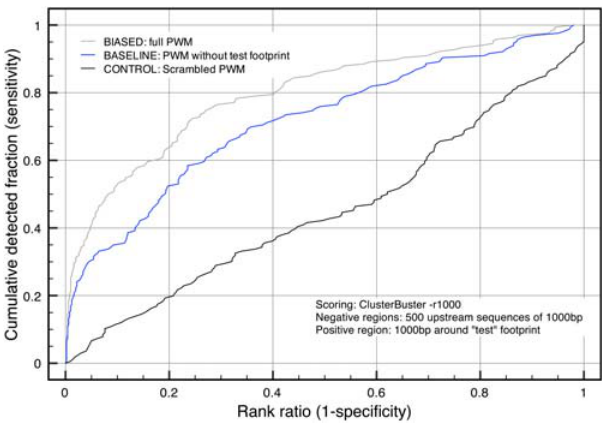
Figure 2. LOOCV performance for homotypic cluster detection on Dmel. For each of the 34 TFs, target sequences are scored with Cluster- Buster, using a PWM built from all known binding sites (grey curve) or from all known binding sites except those located in the region being scored (blue curve). Scrambled PWMs are used as negative controls (black